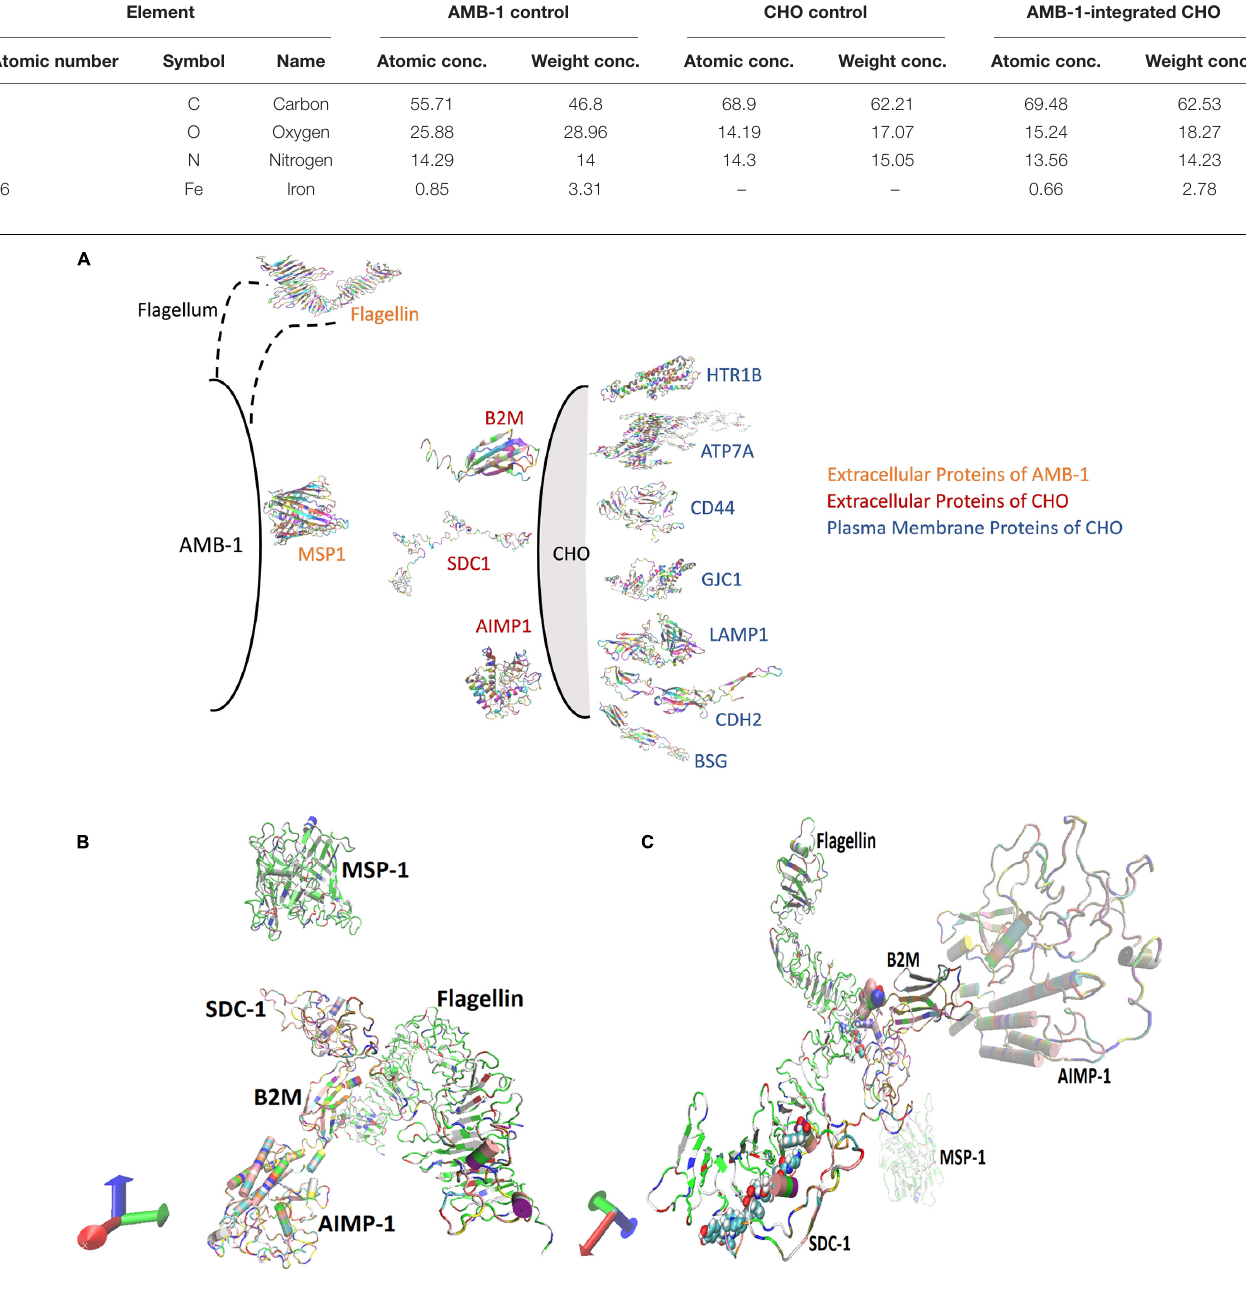
TABLE 1 | Results of the EDAX analysis revealed the elements and their concentration in CHO cells, AMB-1, and AMB-1-integrated CHO cells. Element AMB-1 control CHO control